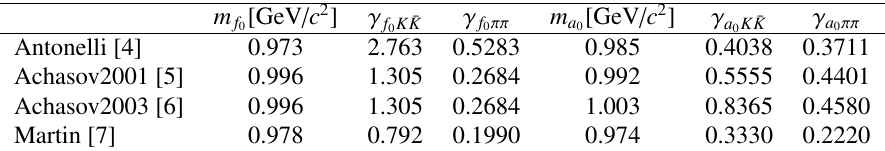
Table 1. The most common parameters describing f 0 (980) and a 0 (980) resonances used in the Lednicky-Lyuboshitz